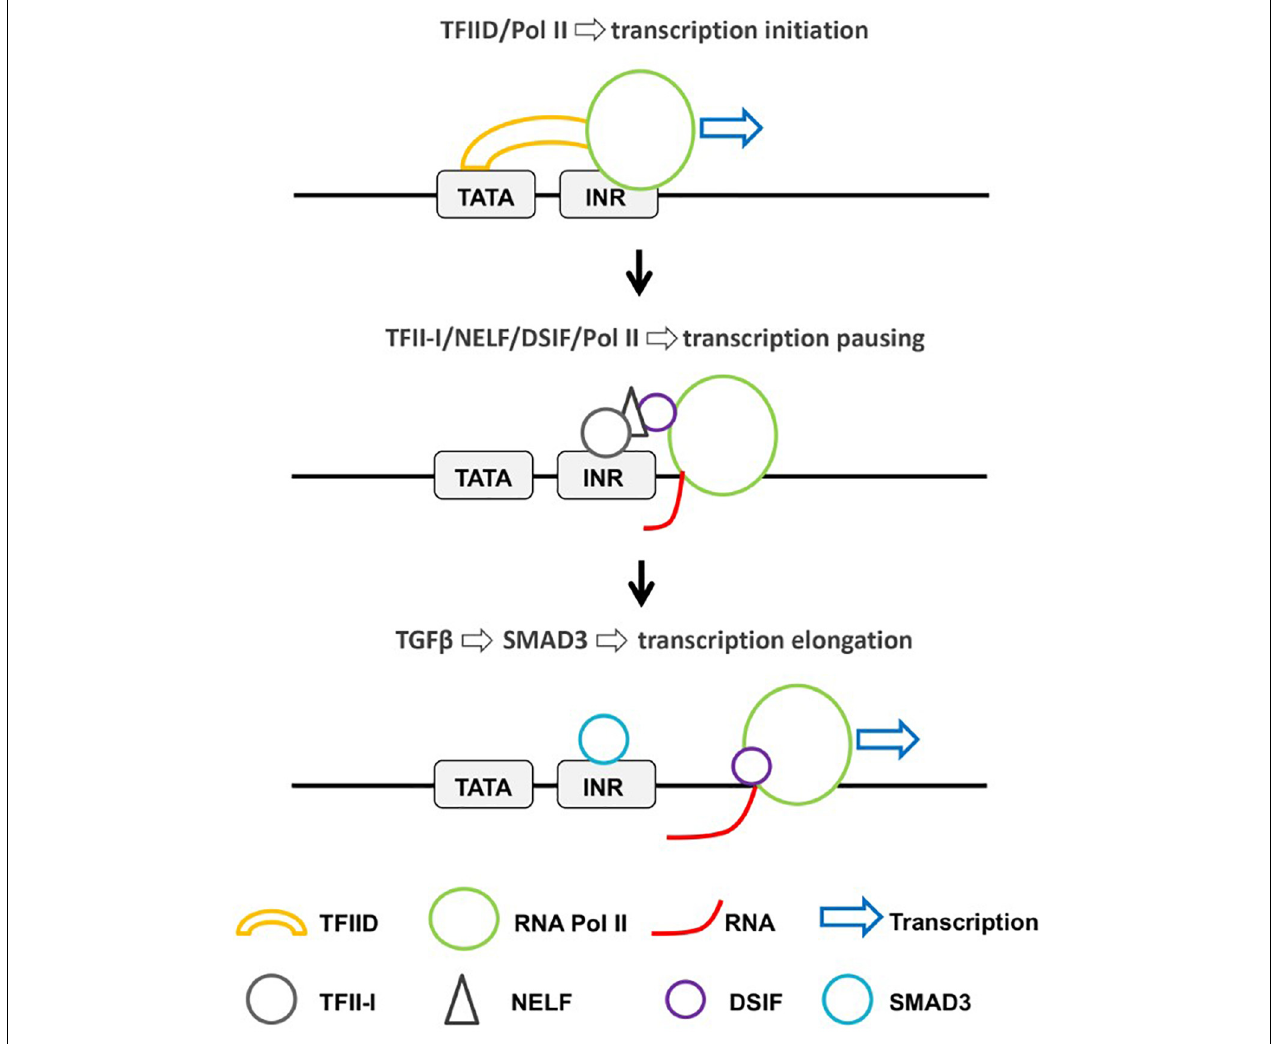
FIGURE 2 | Regulation of Pol II recruitment and transcriptional pausing by TFFI-I. At a subset of TGF- β -inducible genes, TFII-I interacts with NELF and DSIF at a post-initiation step and prevents the release of Pol II from the paused state (McCleary-Wheeler et al., 2020). TGF- β signaling increases the nuclear localization of SMAD3, which displaces TFII-I and converts Pol II into a productive elongation complex.